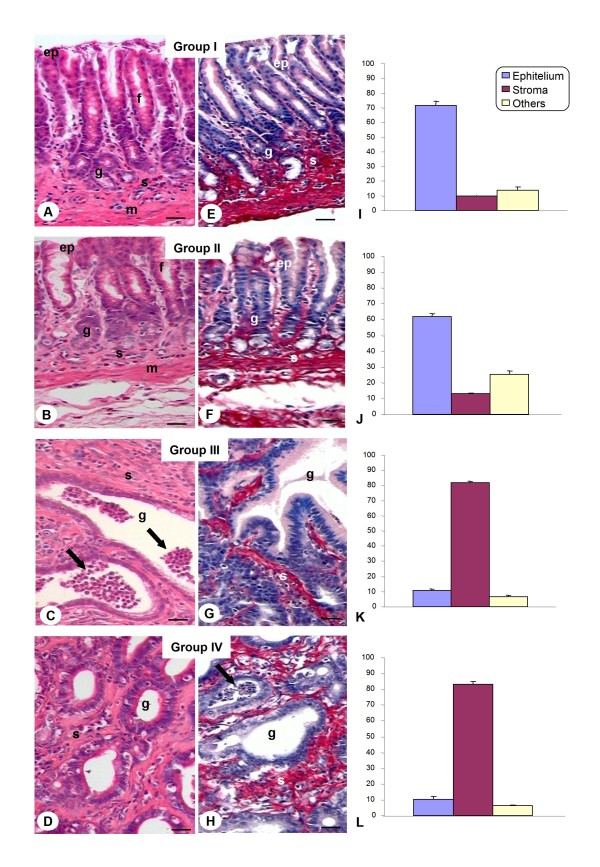
Histological analysis of rat stomachs. A, B, E and F) Pyloric gastric glands (g) surrounded by stroma with collagen fibers (s) observed in the mucosa layer of the groups I and II. Epithelium (ep). Gastric pits (f). Muscularis mucosa (m). C, D, G and H) Pyloric gastric glands (g) constituted by tumoral cells occupied the largest area of the gastric mucosa of the groups III and IV. An accumulation of PMN (arrows) was observed within the glands. Hematoxylin-Eosin (A-D); Picrosirius-Hematoxylin (E-H). Bars: 20 μm. I-L) Tissue compartments (epithelium, stroma, others) volumes of the gastric pyloric mucosa. Values are expressed as mean ± SEM of percentage of relative volume. Groups without lesions (I and II) presented a high relative volume of epithelium (p < 0.05) compared to groups with lesions (III and IV). The presence of adenocarcinoma in the groups III and IV resulted in a significant increase (p < 0.05) of stroma compared to groups I and II.